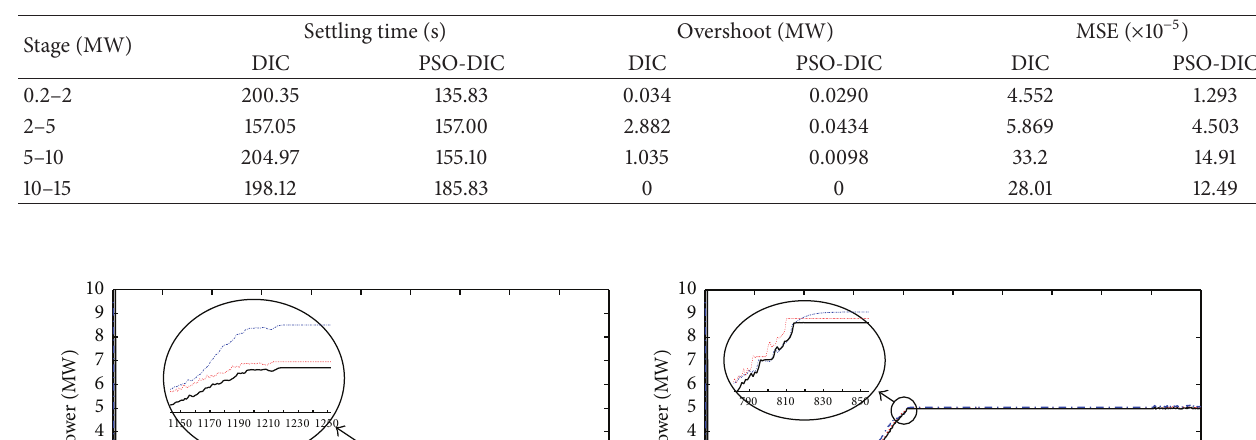
Table 2: Comparison of DIC and PSO-DIC.